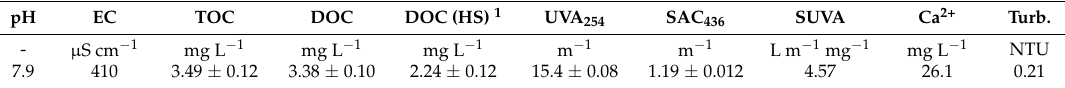
Table 1. Feed water quality during experiments of combined PAC-UF and for adsorption isotherms (average values with standard deviations concerning 2 to 16